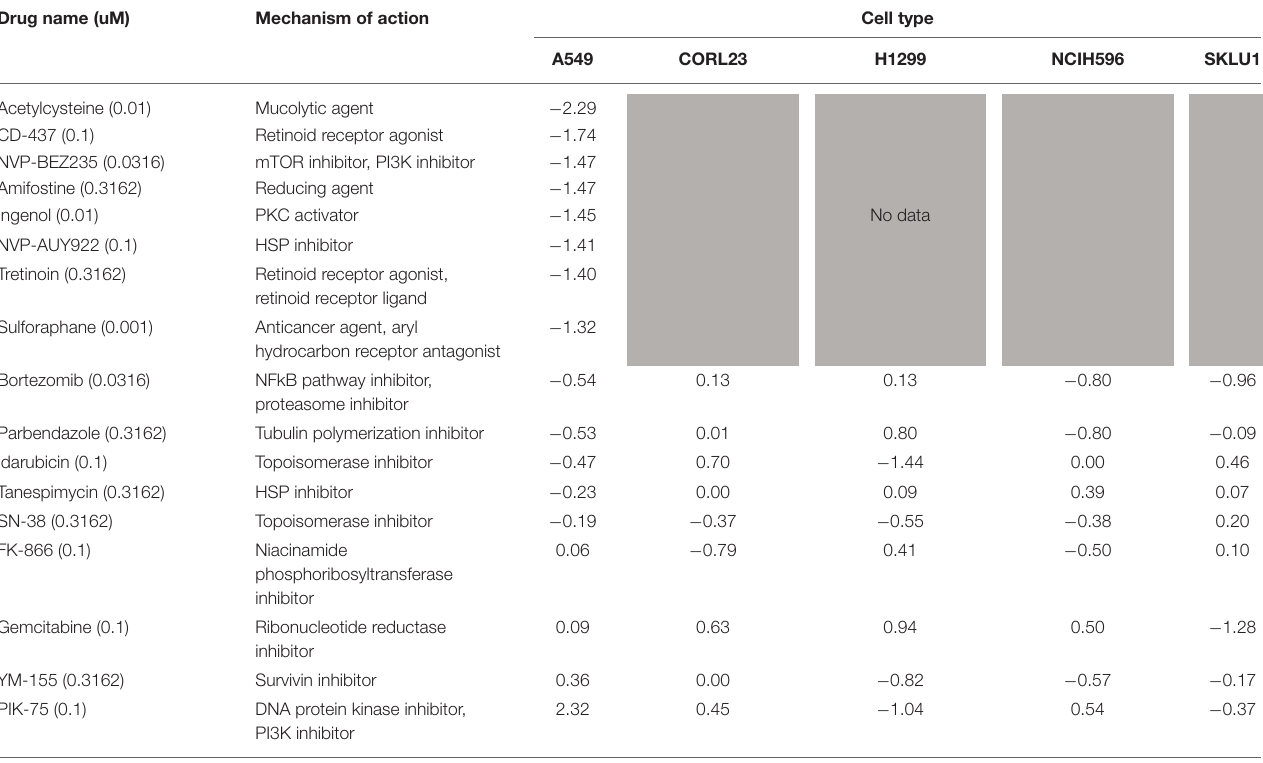
TABLE 1 | The identified 17 small molecules, their optimal doses, mechanisms of action, and ACE2 expression levels in each cell type.